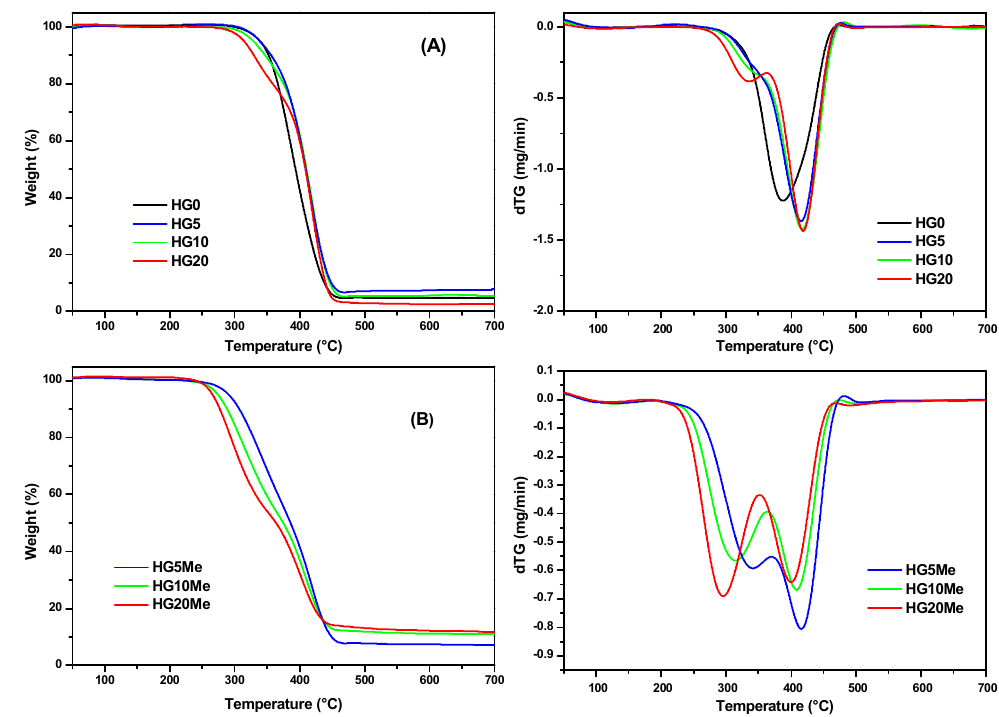
Figure 2. Attenuated total reflectance Fourier Transformation infrared spectroscopy (ATR − FTIR) spectra of ( A ) unmodified and ( B ) methylated hydrogels.